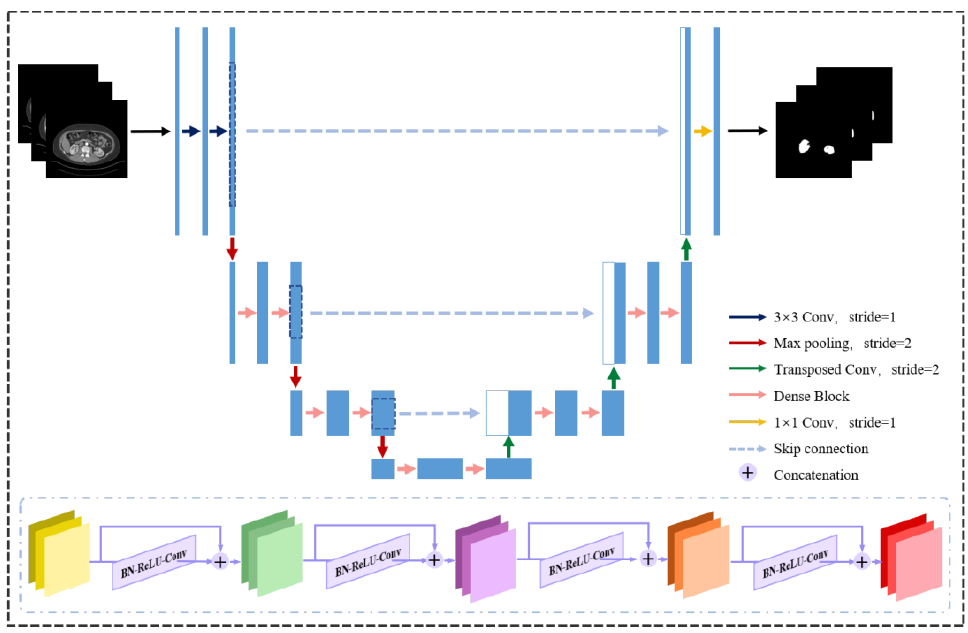
Figure 1. The structure of the generator network model. The structure of the dense block is shown in the box below.